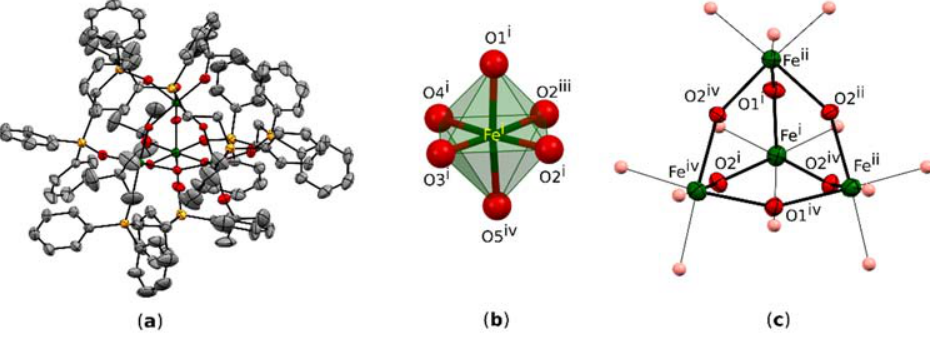
Figure 1. ( a ) The molecular structure of I and the core cation . Displacement ellipsoids are drawn at the 30% probability level; ( b ) the iron coordinate polyhedron; ( c ) view of the adamantane-like ge- ometry exhibited by the [Fe 4 O 6 ] core in I ; symmetry codes: (i) x,y,z; (ii) x,1 − y, ½ − z; (iii) 1 ¼ − x, ¾ − y, ¼ +z iv) 1 ¼ − x, − ¼ +y, ¾ − z; hydrogen atoms are omitted for clarity.